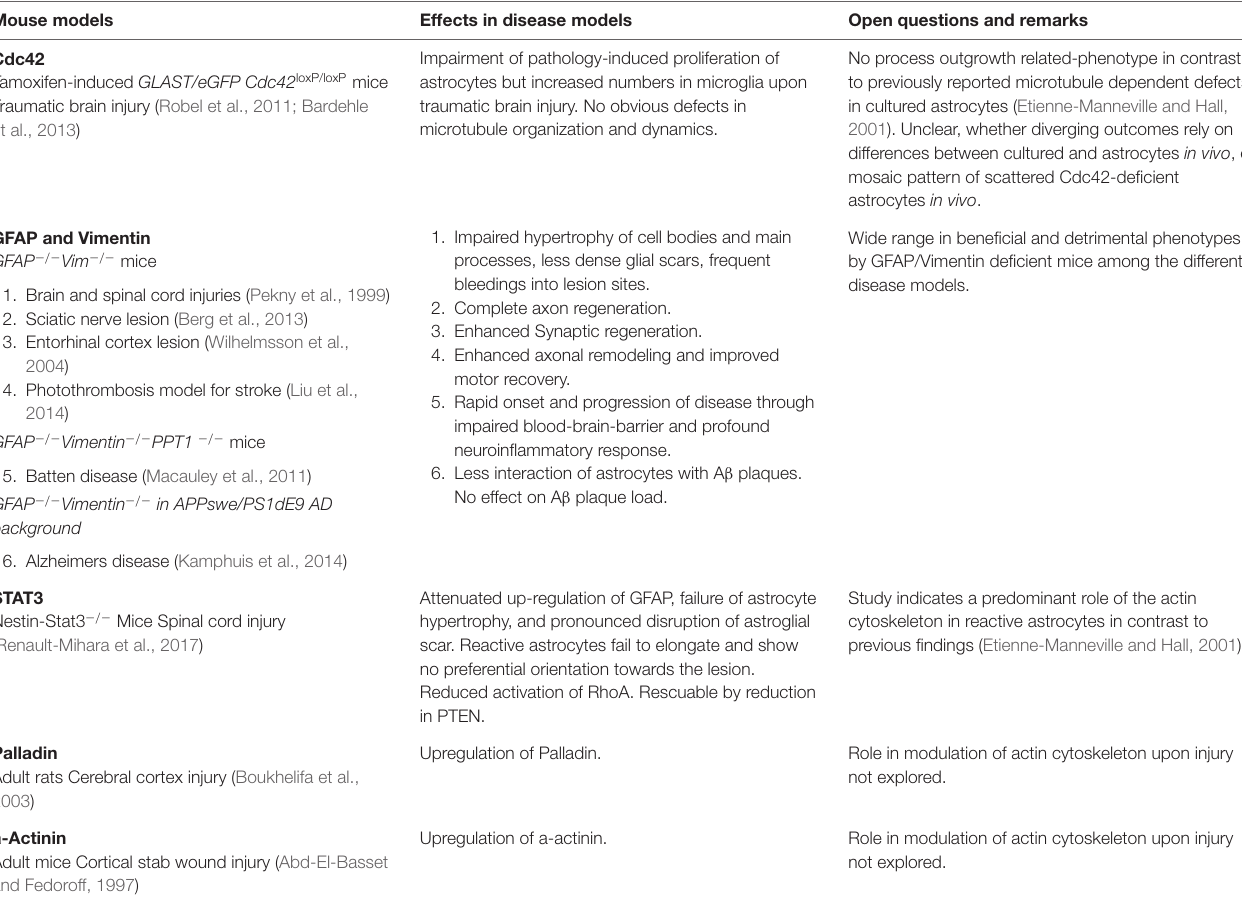
TABLE 1 | Mouse disease models targeting or affecting cytoskeletal regulators in vivo